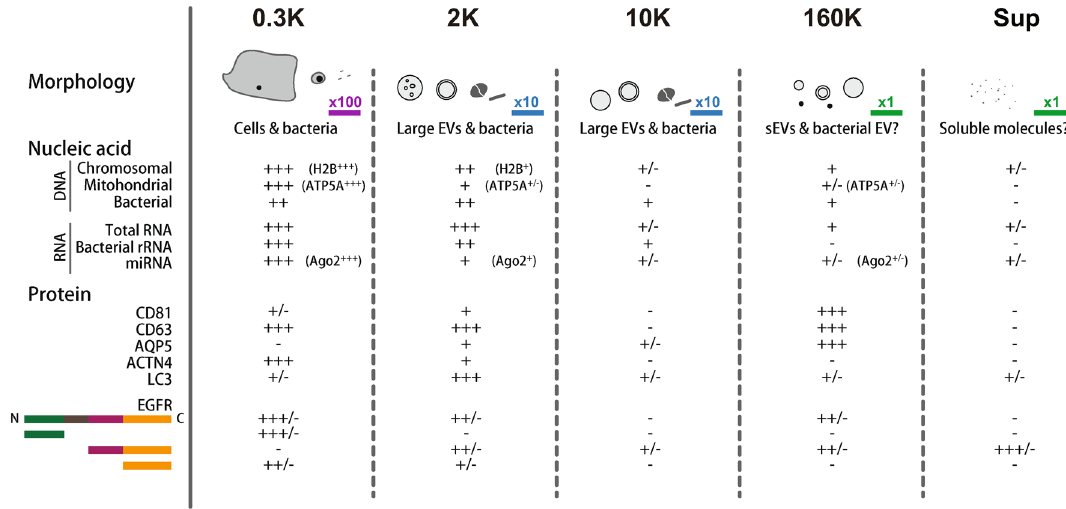
Figure 5. Summary of pentapartite fractionation of human oral fluids. At the top, schematic illustrations of particles observed are shown. The scale bars labeled with × 100, × 10, and × 1 correspond to 20 μm, 2 μm, and 200 nm, respectively. Representative protein markers are shown. “+/−” represents some specimens gave positive signals. Details are described in the “Results”